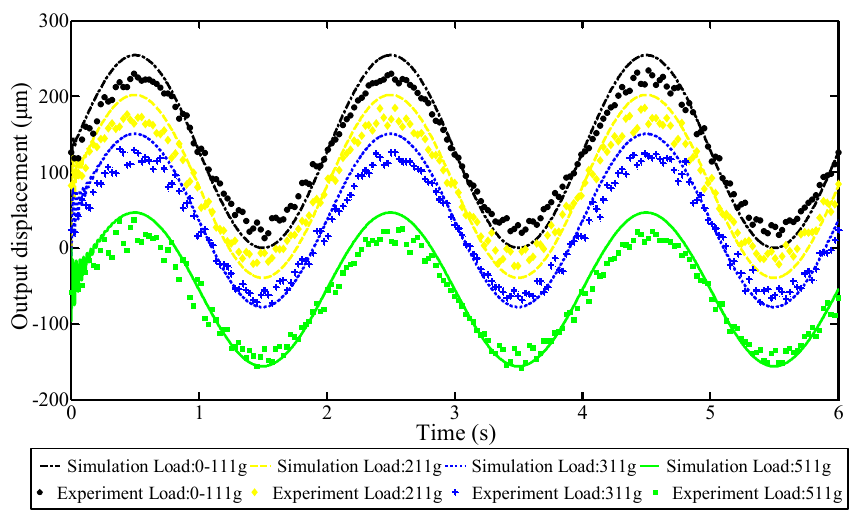
Figure 18. Responses of the compliant platform with various loads to harmonic signals.